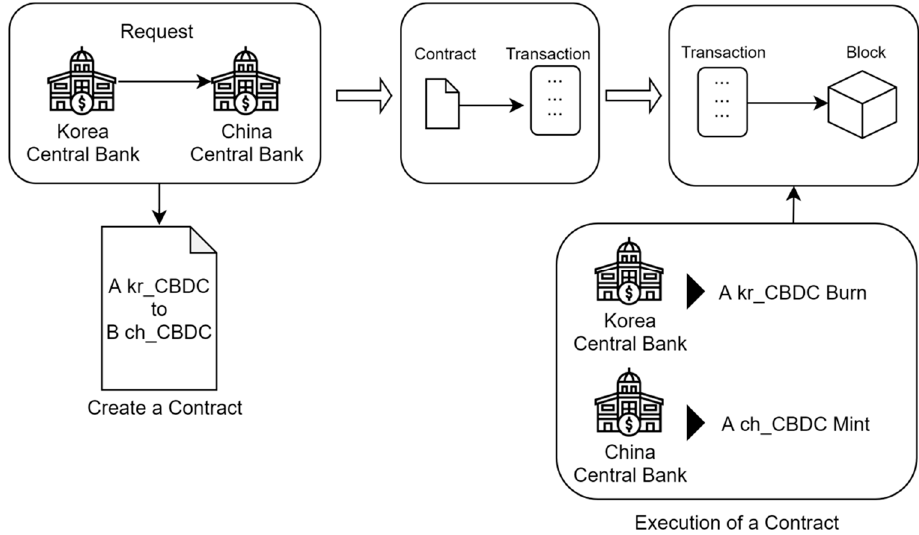
Figure 7. Registration procedure of CBDC.